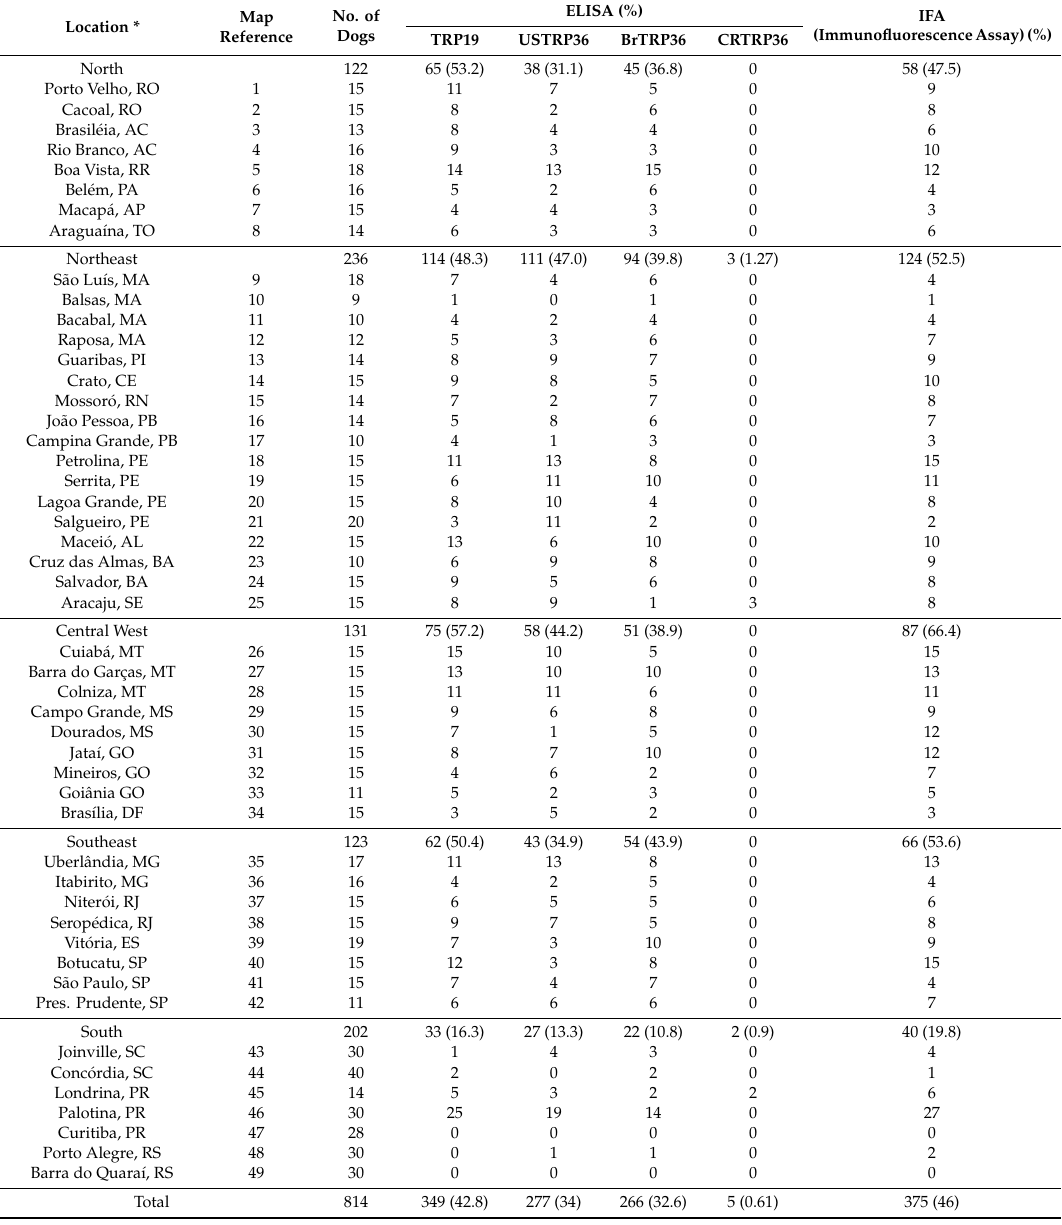
Table 1. Number of sampled and positive dogs in serological assays by city and region in Brazil. ELISA (%) IFA No. of Location * Map (ImmunofluorescenceAssay)(%)TRP19 USTRP36 BrTRP36 CRTRP36 Dogs Reference North